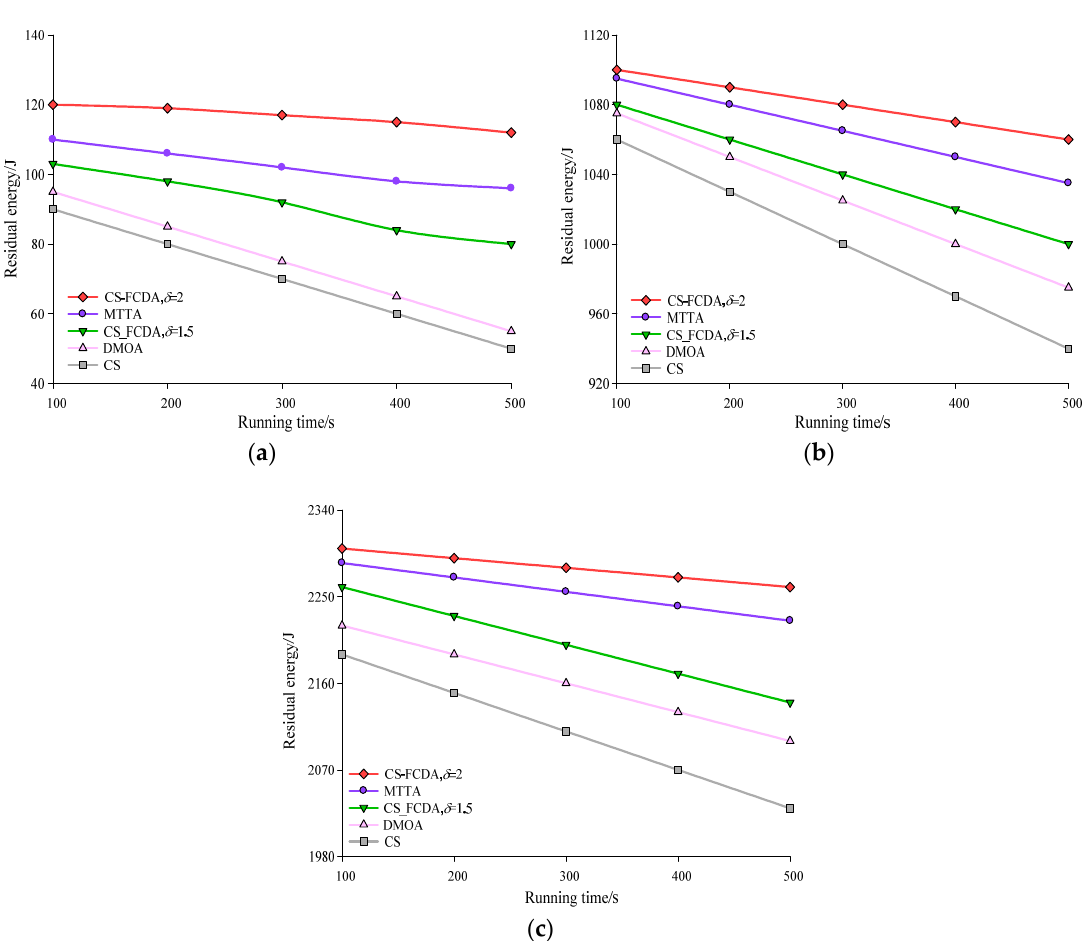
Figure 7. Comparison between network running time and remaining energy. ( a ) Comparison between network running time and remaining energy ( N = 100). ( b ) Comparison between network running time and remaining energy ( N = 300). ( c ) Comparison between network running time and remaining energy ( N = 500).